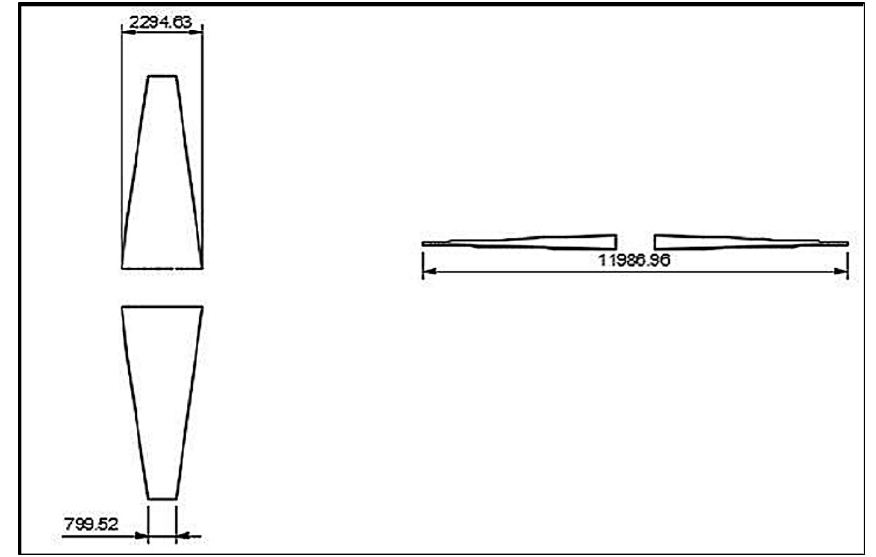
Figure 8. Wing schematic sketch made in Fusion 360. Table 4. Wing parameters. Table 4 specifies the dimensions of the wing.